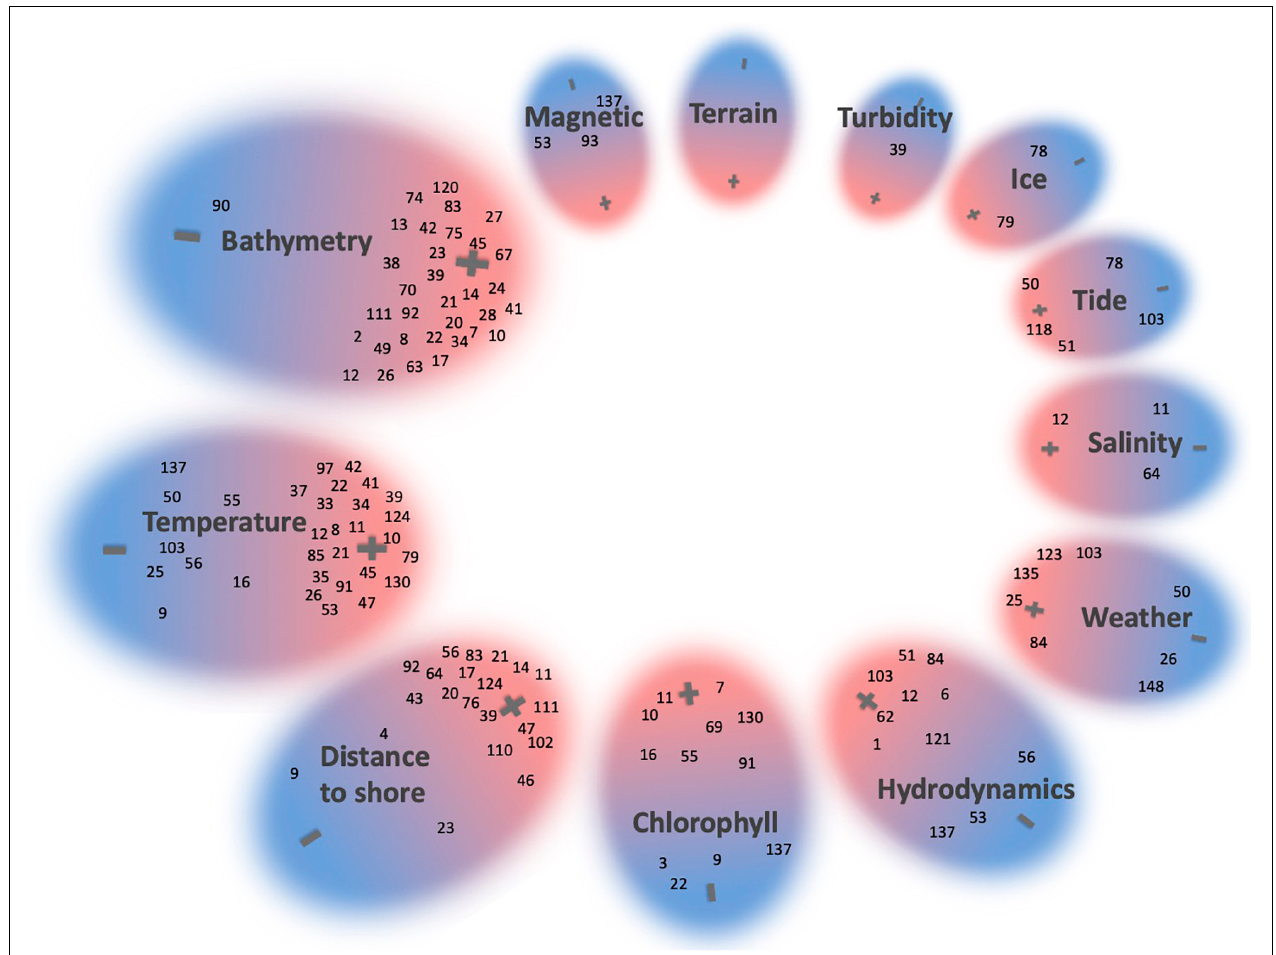
FIGURE 7 | A representation of 73 studies assessing HWs and single environmental drivers. A “+” indicates that an influence of the variable was found and a “–” that no influence of that particular variable was found. Studies identified a weak relationship were placed in the middle. If more than one variable was analyzed, studies were assigned to multiple variables (e.g., temperature, bathymetry, and distance). The size of circles is related to the number of studies testing that particular variable. Studies were indexed (see Supplementary Data for a list of